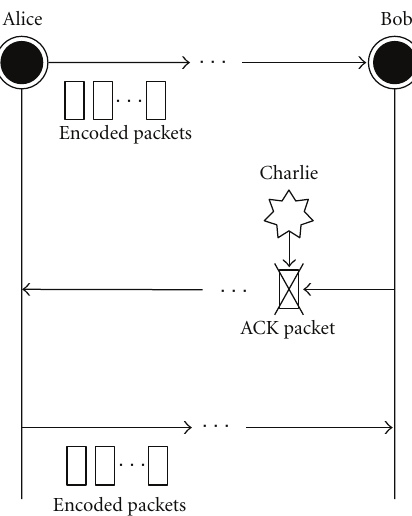
Figure 1: An example of flooding attack. Alice is the source who attempts to send encoded packets to the destination, Bob. Bob is supposed to forward an ACK to Alice once he successfully decodes a message. The adversary, Charlie, drops or delays the ACK: Alice never stops to transmit packets to